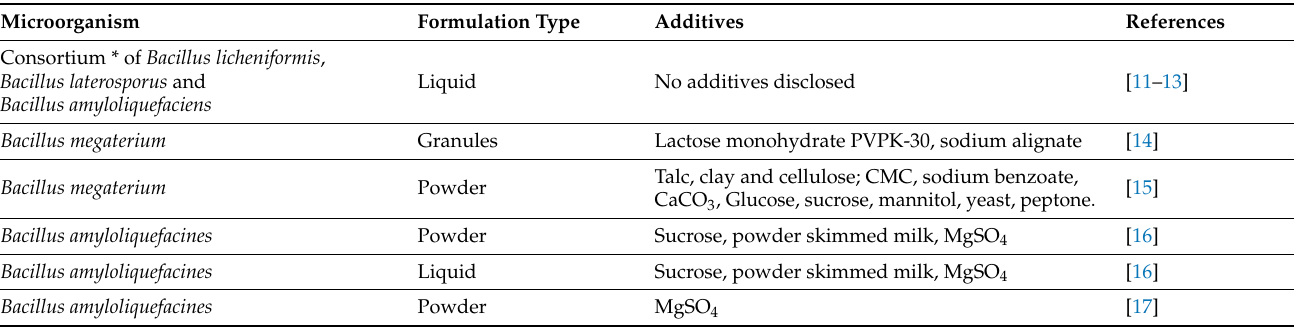
Table 1. Bacillus spp. biostimulant